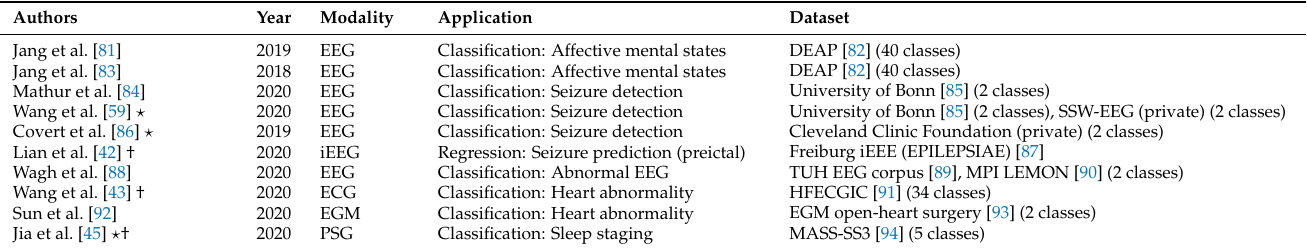
Table 2. Summary of GCN approaches adopted to electrical-based analysis and their